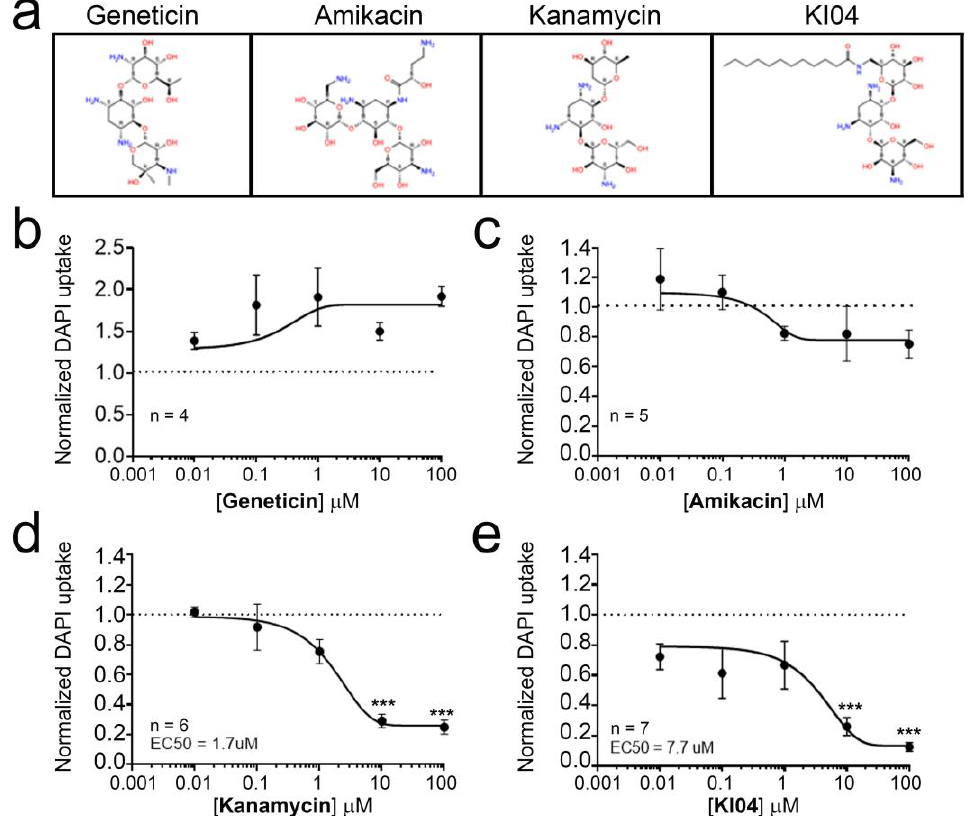
Figure 2. KI04 acts as an inhibitor of Cx46 hemichannels. HeLa cells transfected with Cx46tGFP were placed in DCFS complemented with 10 µ M DAPI, and time-lapse experiments were performed. ( a ) Chemical structure of aminoglycosides and KI04 that were used in this work. Dose response of ( b ) geneticin ( n = 4), ( c ) amikacin ( n = 5), ( d ) kanamycin ( n = 6), and ( e ) KI04 ( n = 7) on DAPI uptake. In each plot, the rate of DAPI uptake was normalized against the rate of DAPI uptake measured in the absence of KI04 (dot line). For each experiment, DAPI fluorescence intensity was measured in 16 cells, showing GFP or Cx46tGFP fluorescence. p < 0.01 =